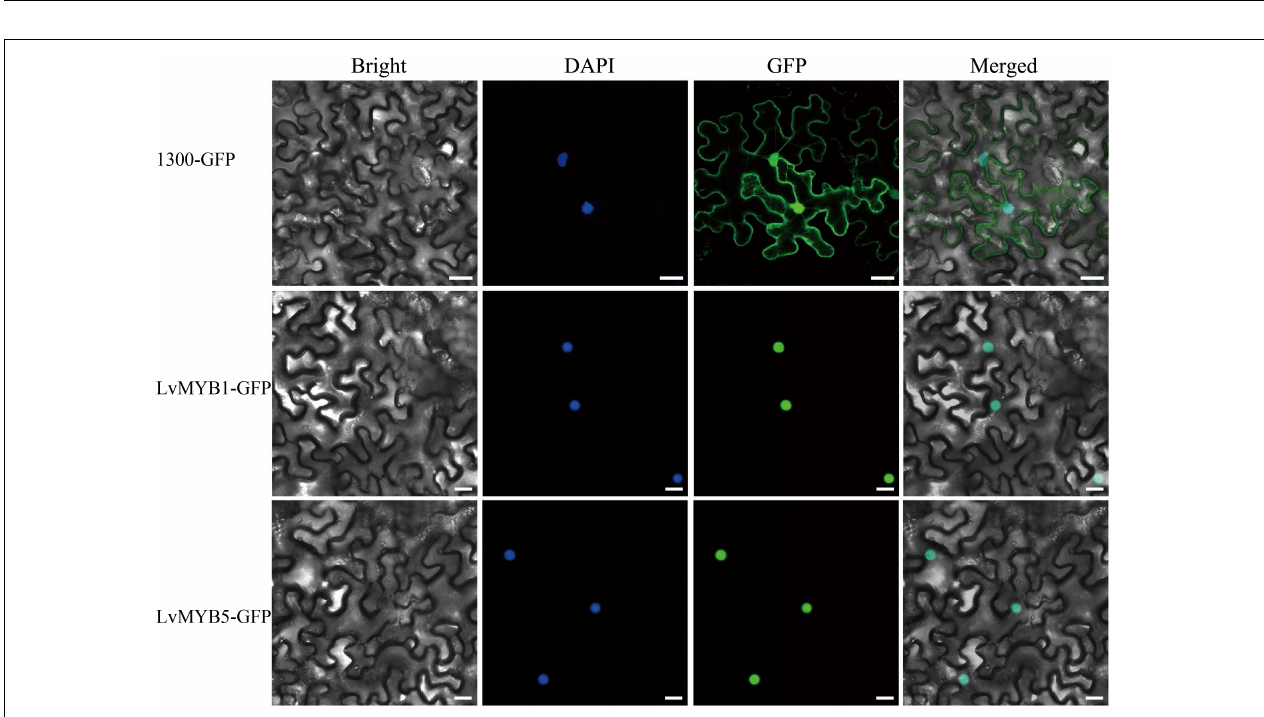
FIGURE 2 | Subcellular localization of LvMYB5-GFP and LvMYB1-GFP in leaf epidermal cells of Nicotiana benthamiana . (Scale bars = 25 µ m). Nuclei were counterstained with DAPI (4 (cid:48) ,6-diamidino-2-phenylindole). Experiments were repeated three times.